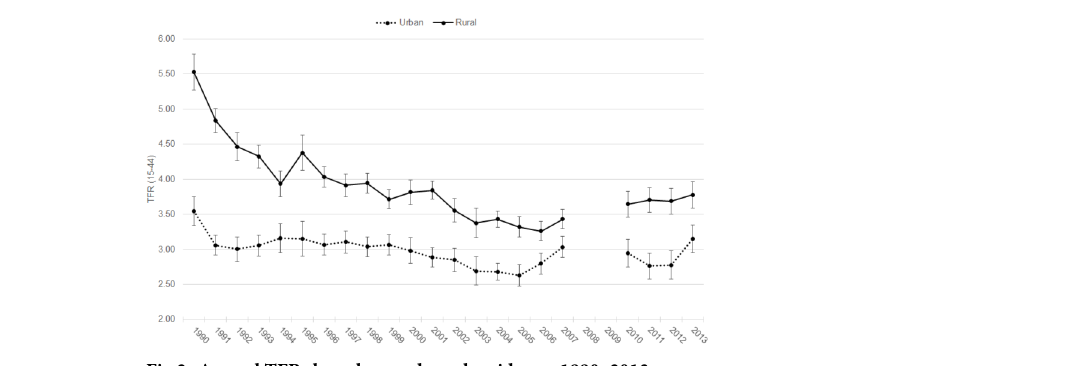
Fig 2. Annual TFRs by urban and rural residence, 1990–2013.